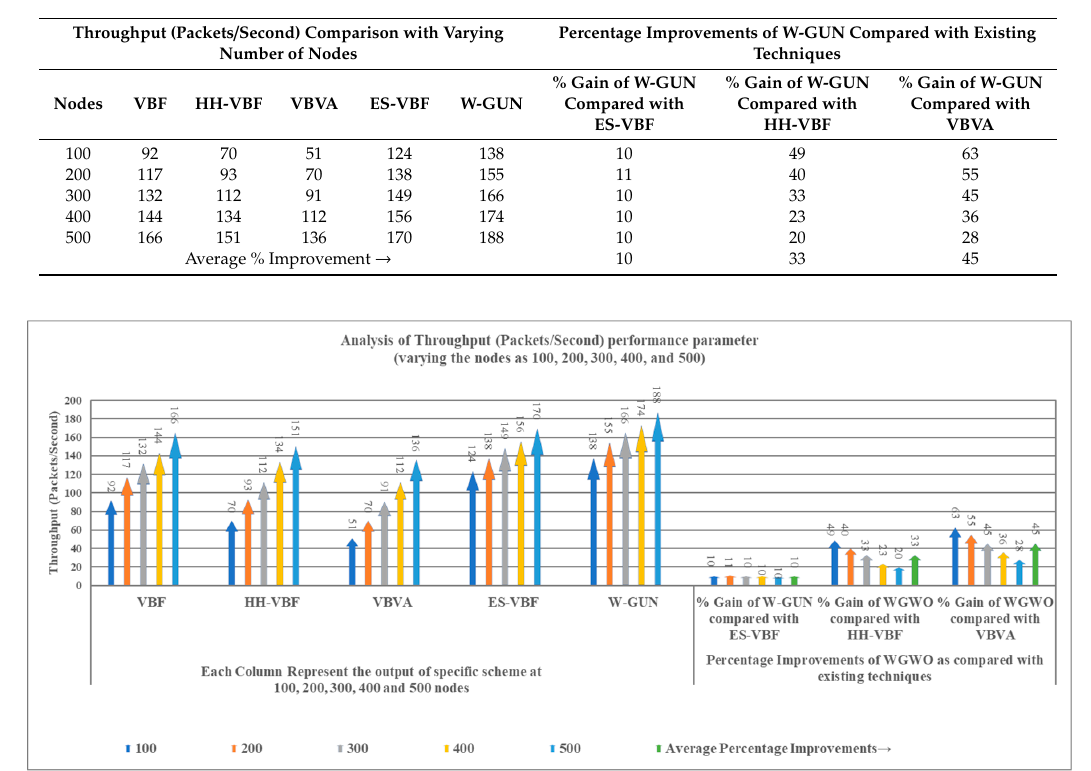
Figure 11. Throughput versus the number of underwater nodes. Table 5. Descriptive performance observation of W-GUN in terms of throughput. Table 5. Descriptive performance observation of W-GUN in terms of throughput.